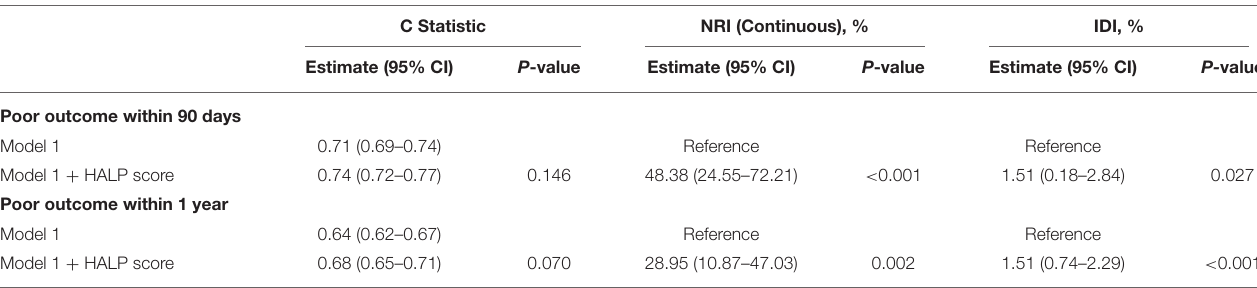
TABLE 3 | Reclassification and discrimination statistics for poor outcome by HALP